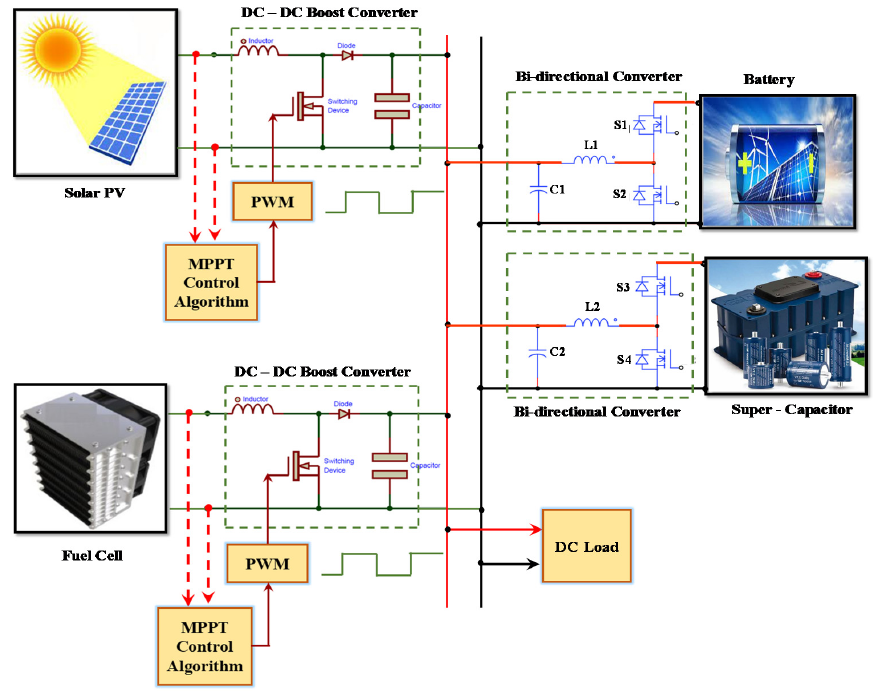
Figure 4. Fuzzy controller scheme for boost converter in DC MG.